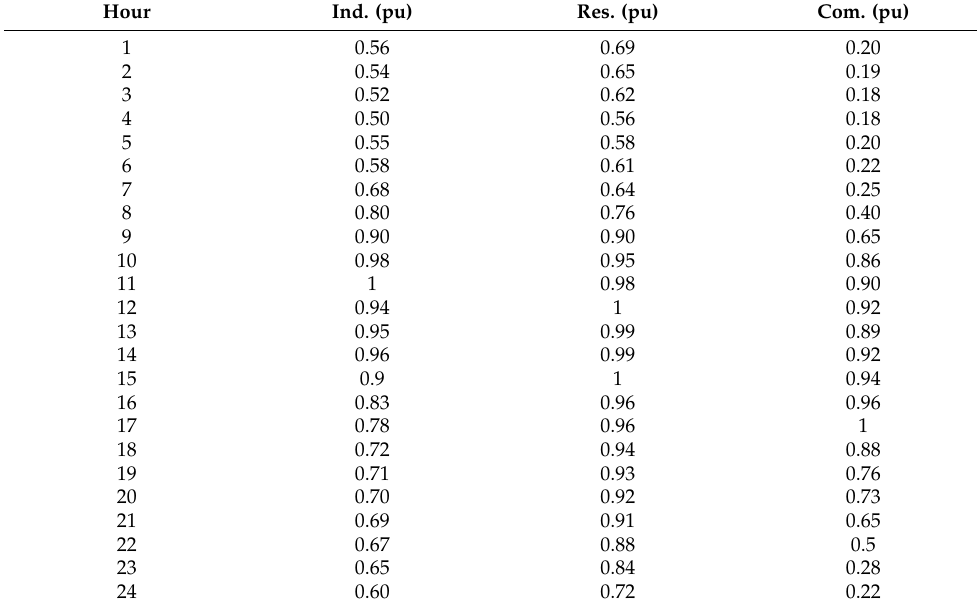
Table 3. Expected percentages of consumption for residential, industrial, and commercial